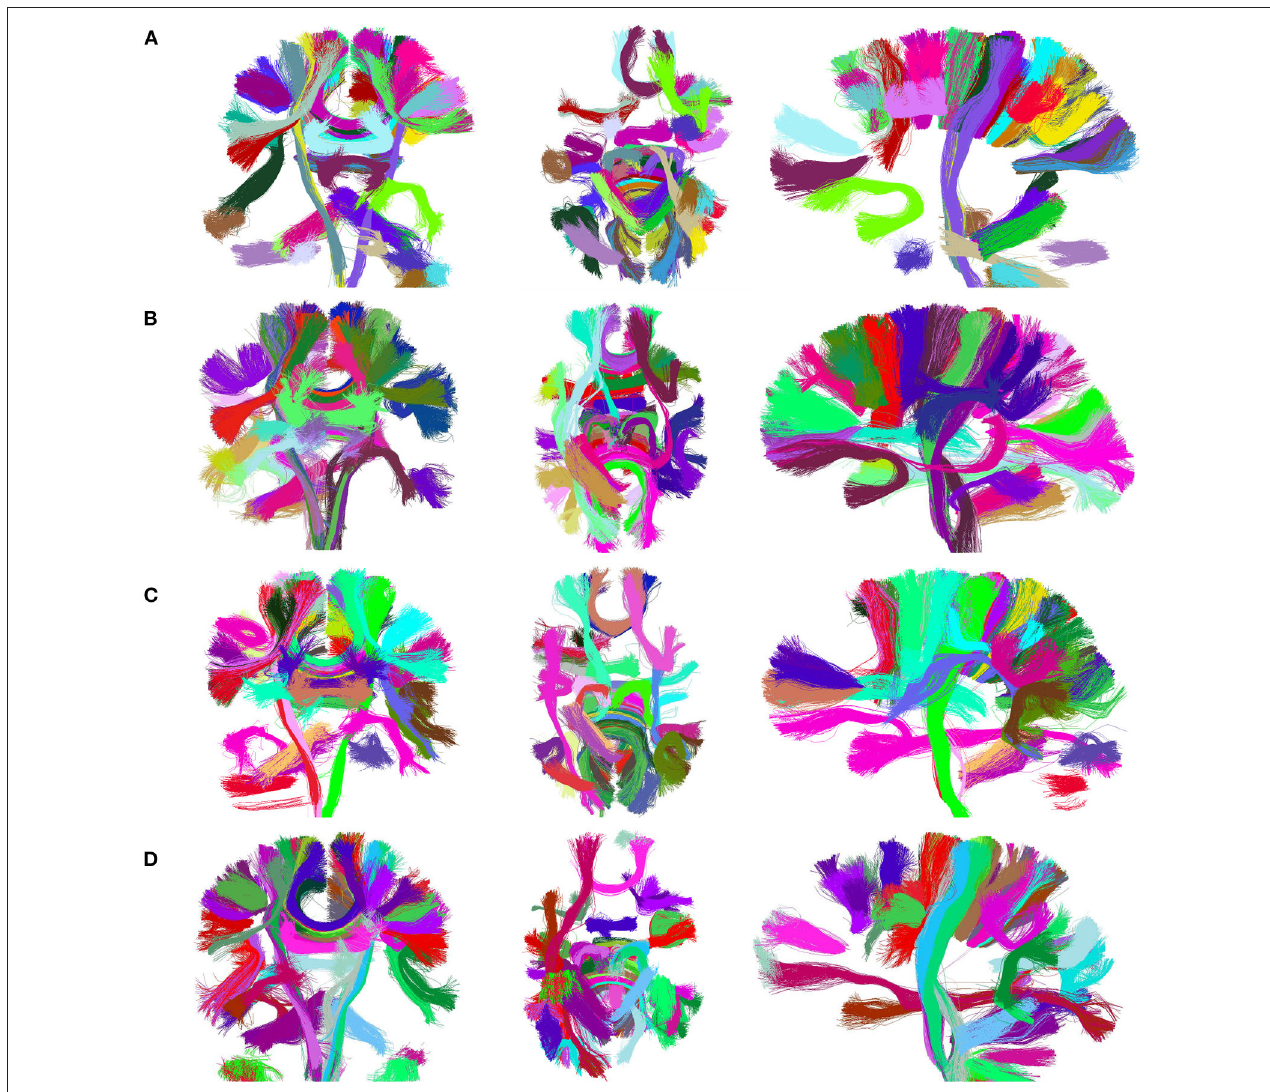
FIGURE 7 | Visualization of 50 largest final clusters for a subject, for FFClust and the three parallel methods (CeFFC, CkpFFC, and CkFFC). The CeFFC alternative obtains well formed clusters with a higher brain area coverage than FFClust for this group of clusters. FFClust shows more compact clusters than the parallel alternatives. (A) FFClust. (B) CeFFC. (C) CkpFFC. (D)